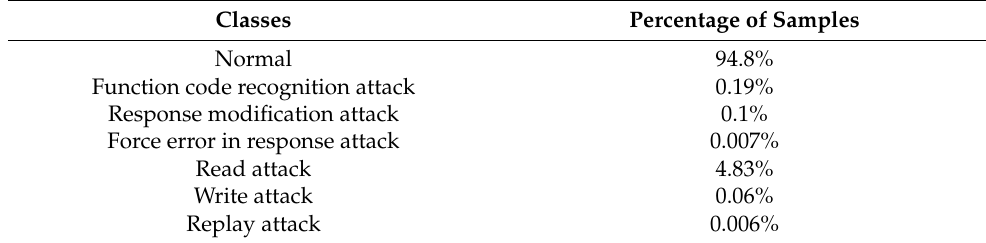
Table 2. Attack classes of the Electra Modbus dataset